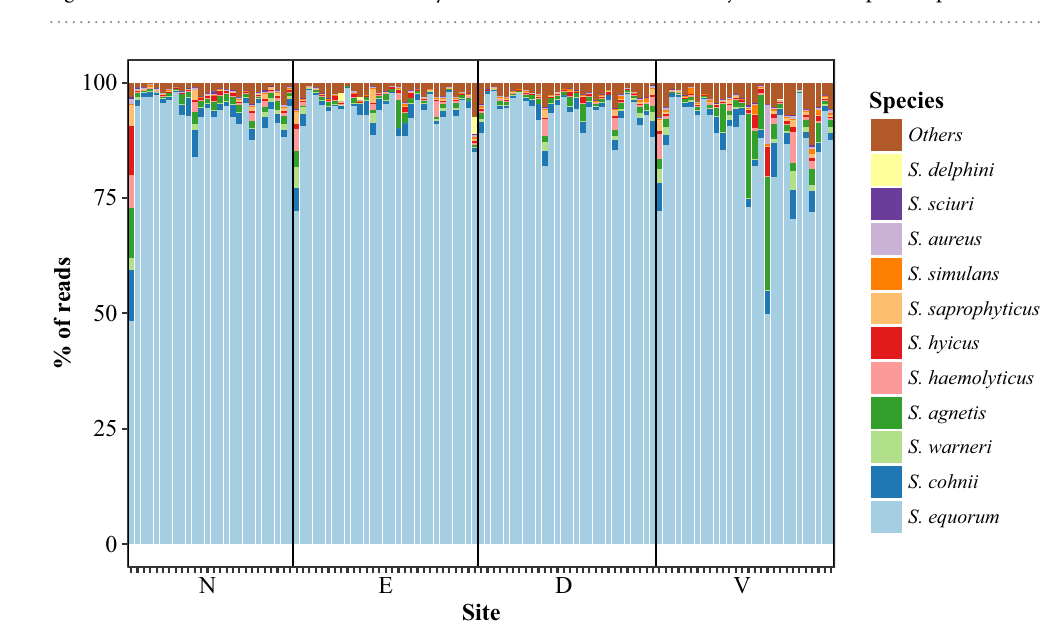
Figure 3. The most abundant and otherwise interesting bacterial genera from 16S rRNA gene sequencing. N: nose, E: ear, D: dorsal skin surface, V: ventral skin surface. Differences are tested with Kruskal-Wallis and, if significant, different medians are denoted by different letters. P-values are adjusted for multiple comparisons.